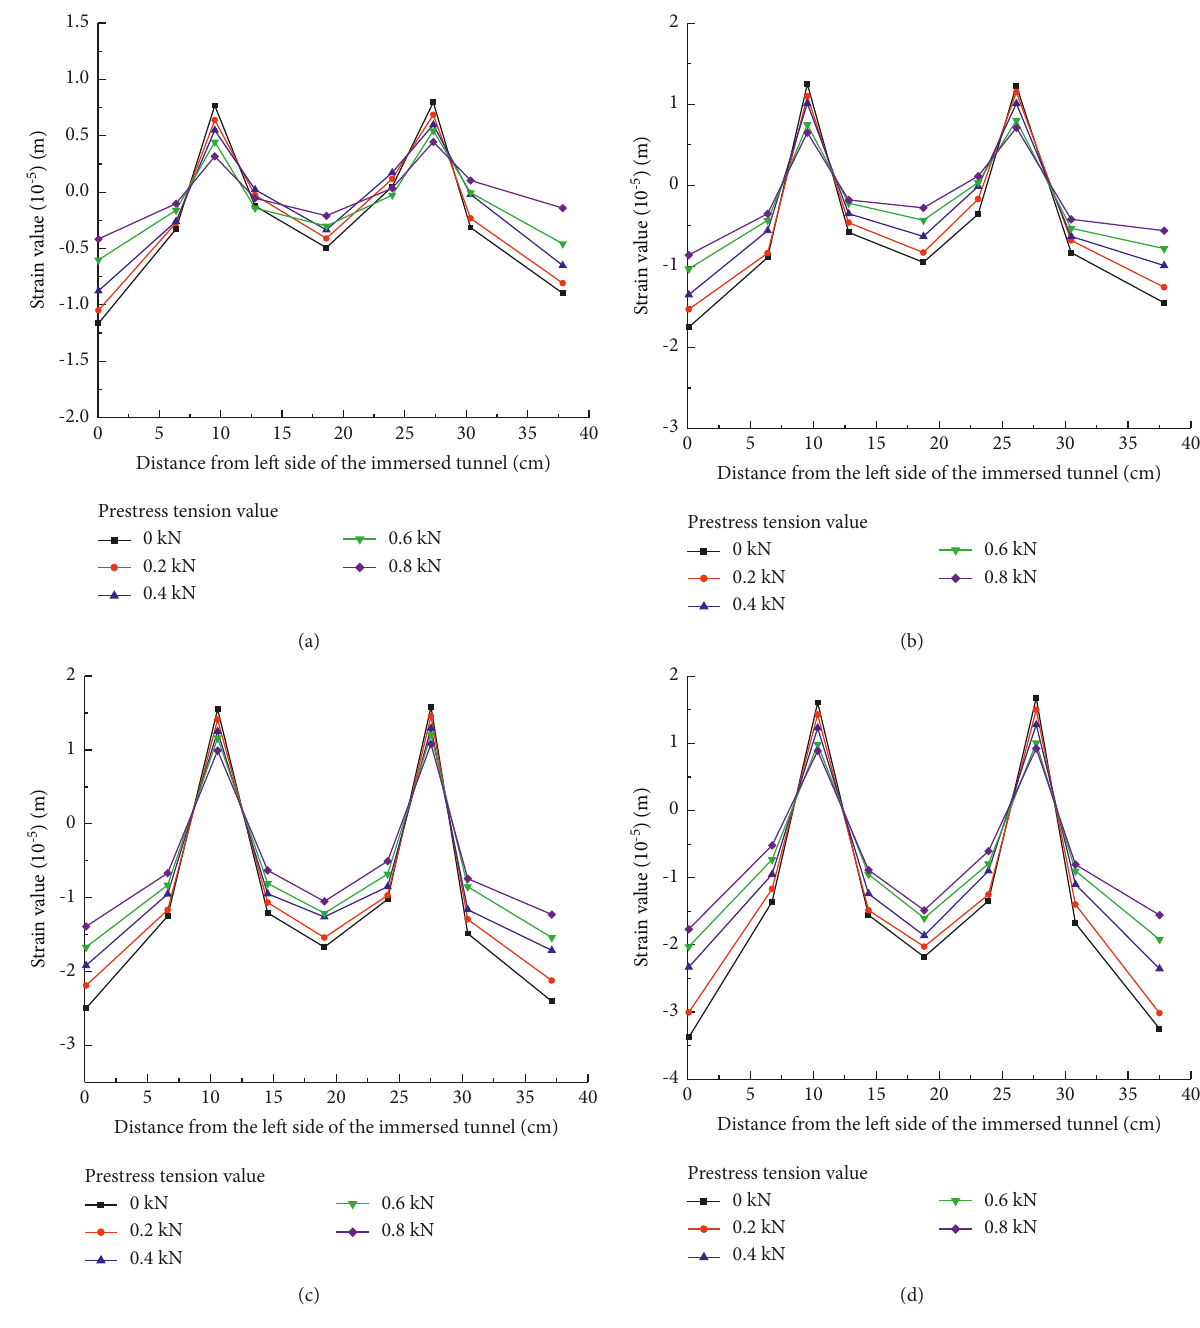
Figure 20: Strain distribution curve of the immersed tunnel bottom plate: (a) 5kPa, (b) 10kPa, (c) 15kPa, and (d)